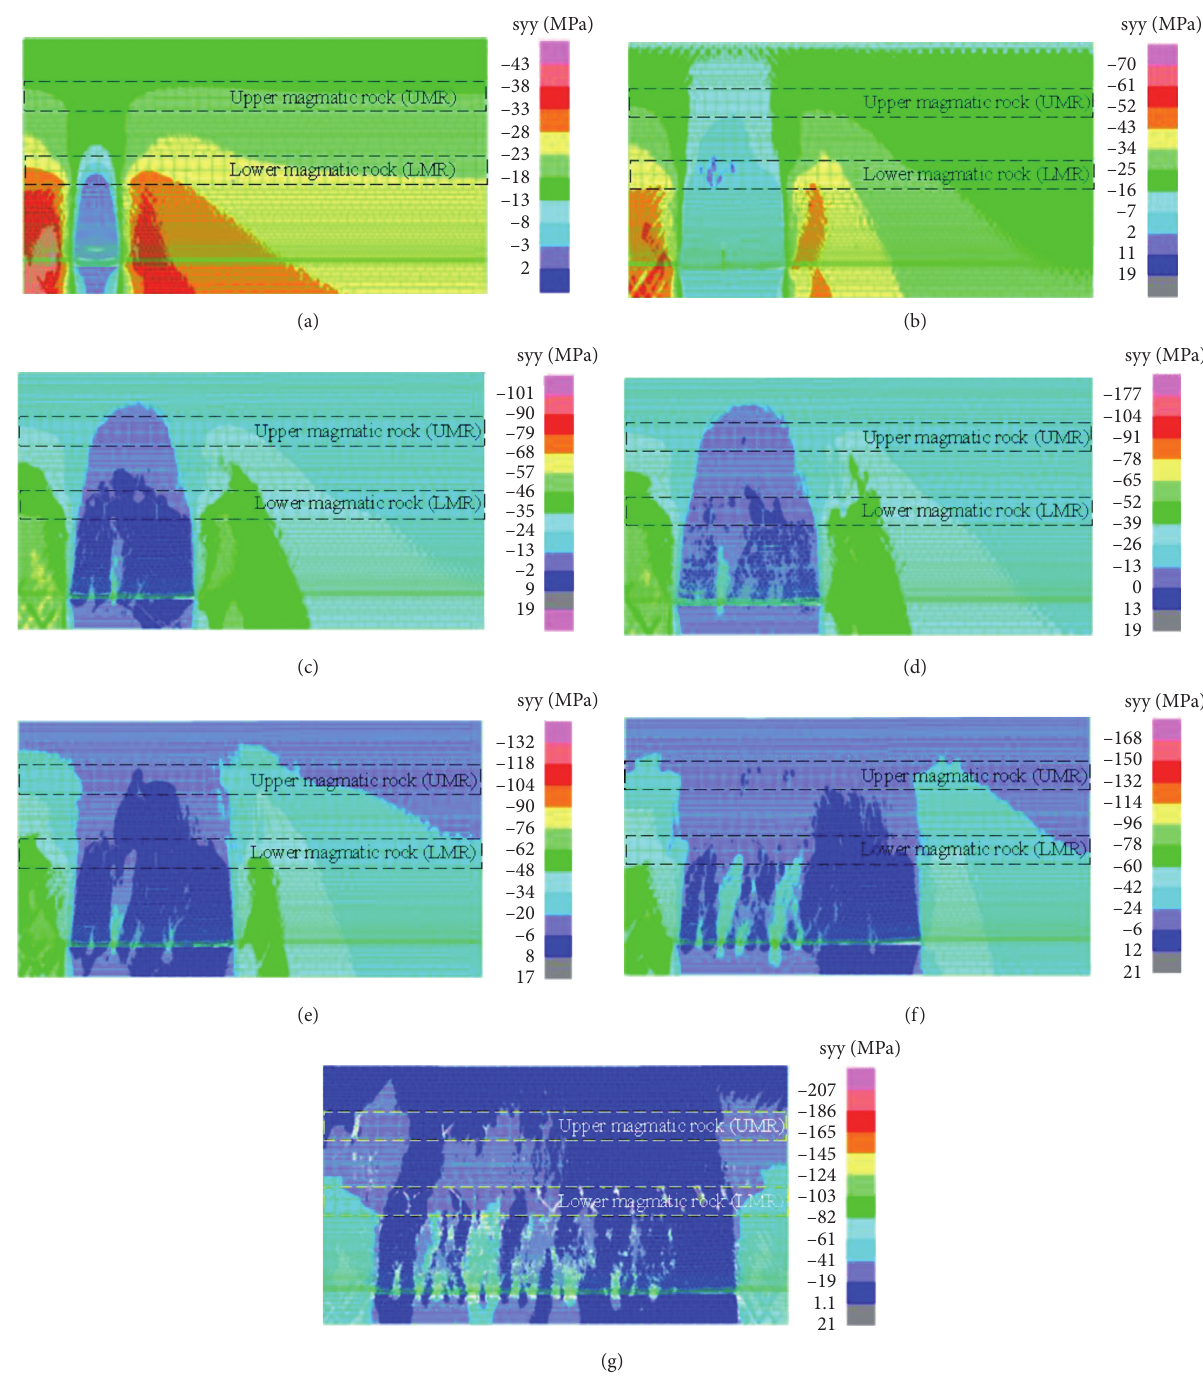
Figure 5: Stress distribution and evolution with typical mining states. (a) 70 m. (b) 160 m. (c) 190 m. (d) 220 m. (e) 250 m. (f) 370 m. (g) 550